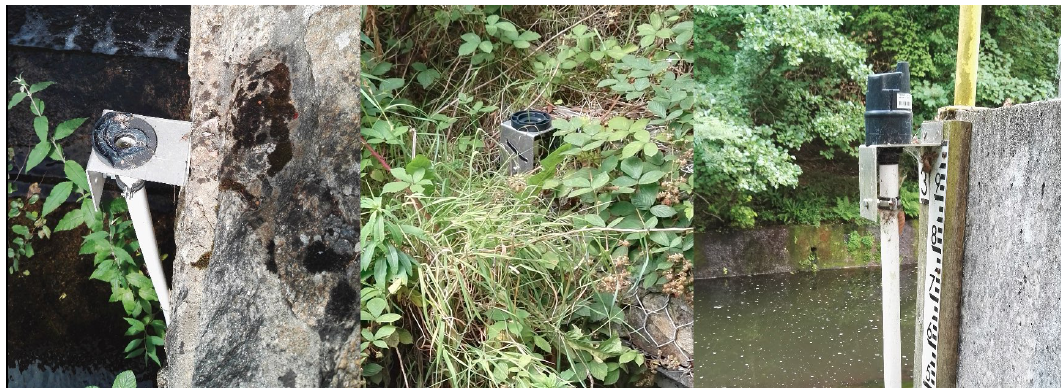
Figure 6. Edmondstown sensor unit ( left ) is removed by brute force. Base bracket is broken. Brehons Chair unit ( middle ) is unscrewed. Base bracket is intact. Both of these units are clearly visible from a public road and easy to reach. Spider webs were found in the tube of the Bohernabreena sensor unit ( right ), which caused invalid